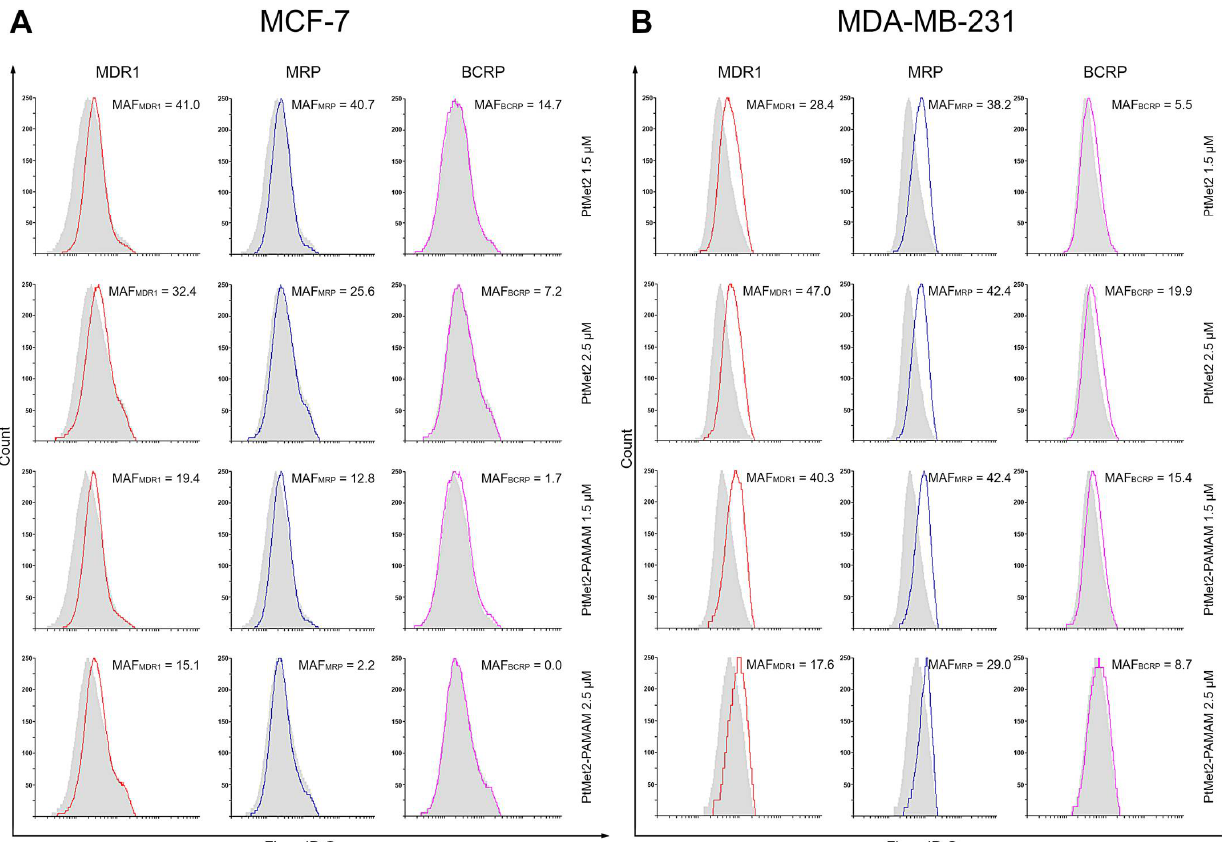
Figure 18. Flow cytometry analysis of MCF-7 ( A ) and MDA-MB231 ( B ) cells treated for 24 h with PtMet2 and PtMet2– PAMAM (1.5 μM and 2.5 μM, both). Cells incubated with Efflux Green Detection Reagent with and without specific inhibitors (Verapamil, MK-571 and Novoiobin). Gray histograms show the fluorescence of the inhibitor-treated samples and tinted histograms show the fluorescence of the treated cells (MDR1—red histogram, MRP—blue histogram, BCRP—purple histogram). The difference in fluorescence is indicative of corresponding protein activity. The numbers in the upper right corners are MAF scores (multidrug resistance activity factors), quantitative characteristics of multidrug resistance.